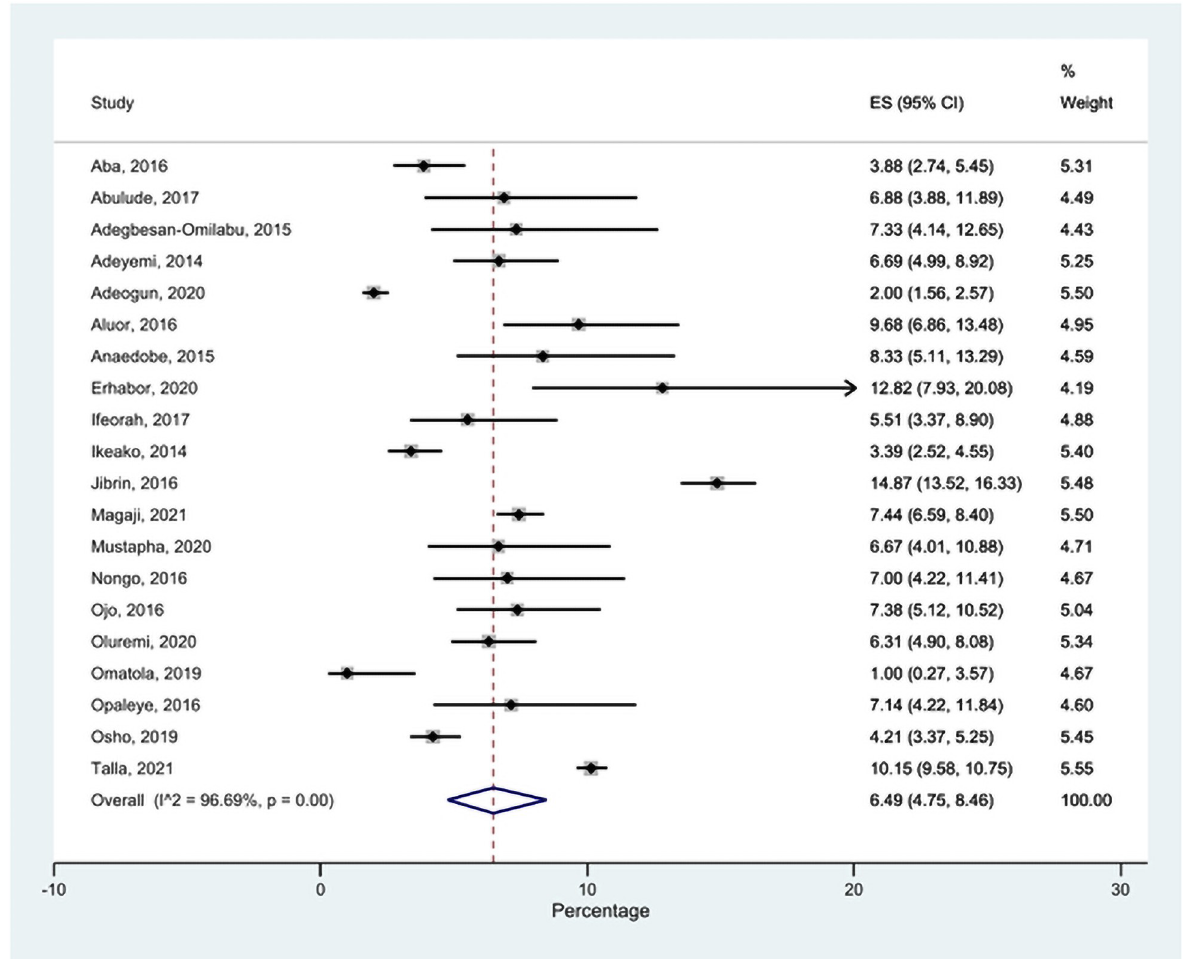
Fig 2. Forest plot of HBV prevalence among pregnant women in Nigeria,